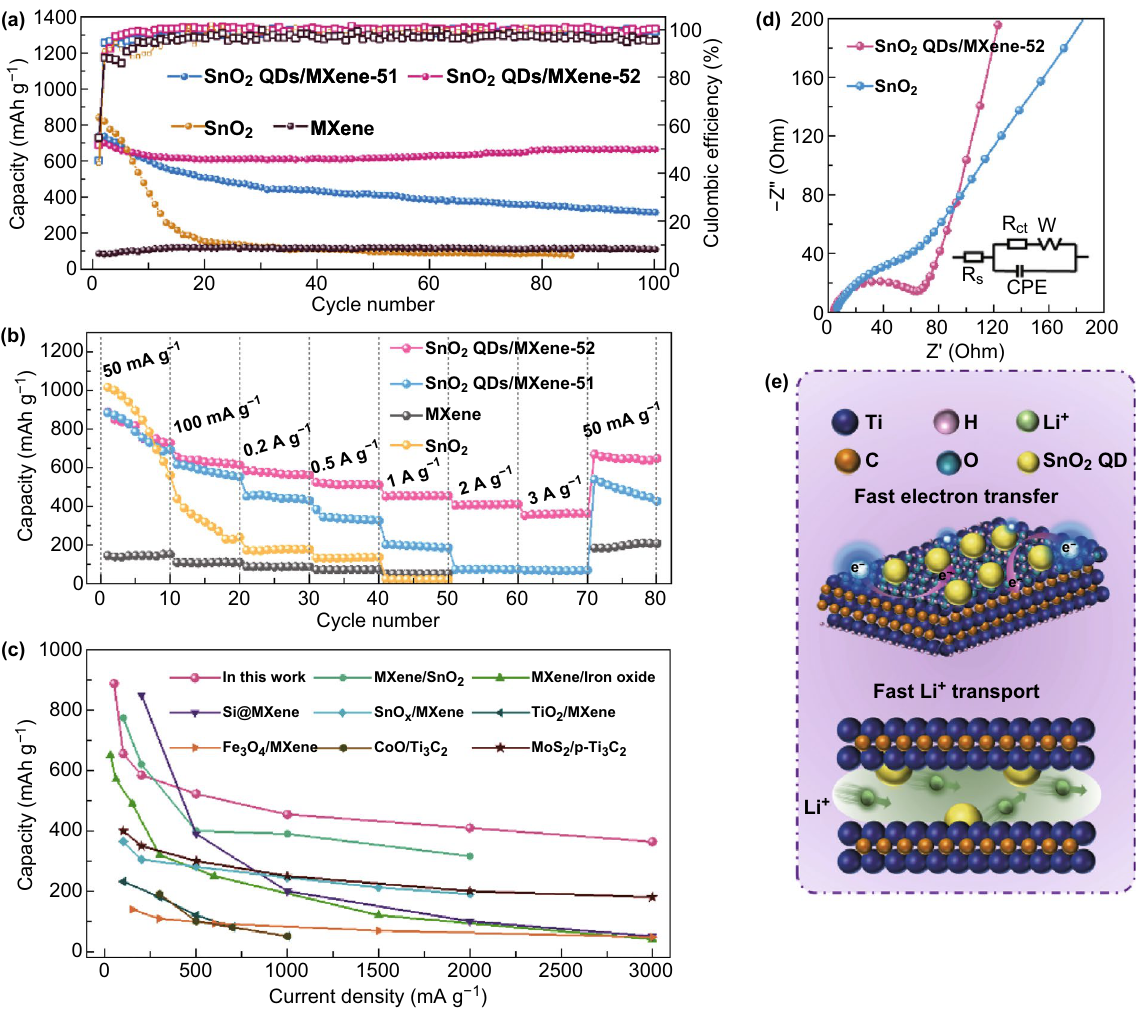
Fig. 5 a Cycle stability, b rate performance of all the samples as LIB electrodes. c Comparison of rate capacity between the SnO 2 QDs/MXene‑ 52 and other MXene‑based electrode materials reported for LIBs. d Nyquist plots of the SnO 2 QDs/MXene‑52 and the pure SnO 2 electrodes; e energy storage mechanism of the 0D–2D SnO 2 QDs/MXene